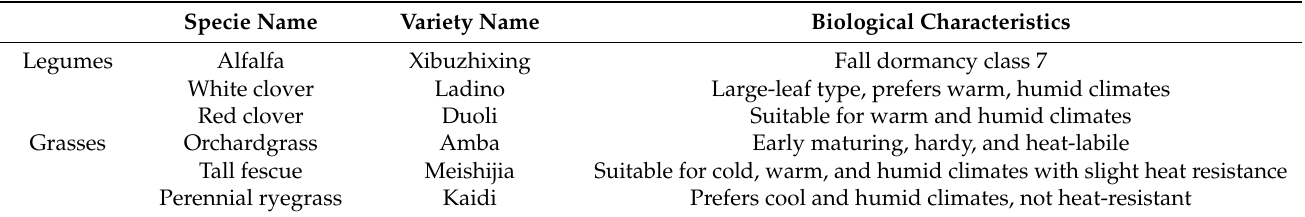
Table 1. Variety names and biological characteristics of selected legume and grass species.